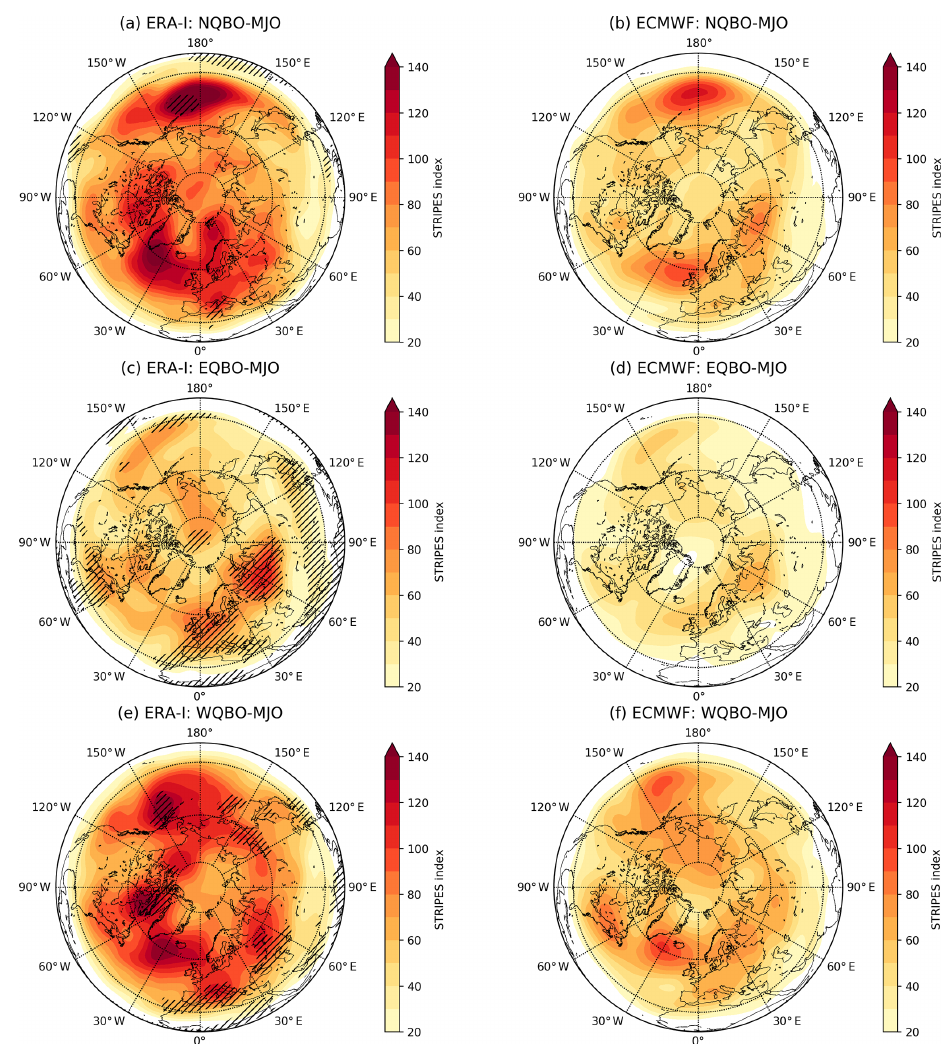
Figure 2. STRIPES values for (a, c, e) ERA-Interim and (b, d, f) ECMWF for all (a, b) NQBO–MJO, (c, d) EQBO–MJO, and (e, f) WQBO– MJO events. (a, c, e) Black hatching denotes STRIPES values that are statistically larger than expected by chance at 90% confidence in ERA-I. Significance is only calculated for